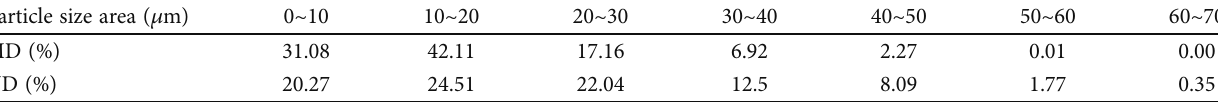
Table 1: Percentage of cumulative distribution of MD and ND in di ff erent particle size intervals.